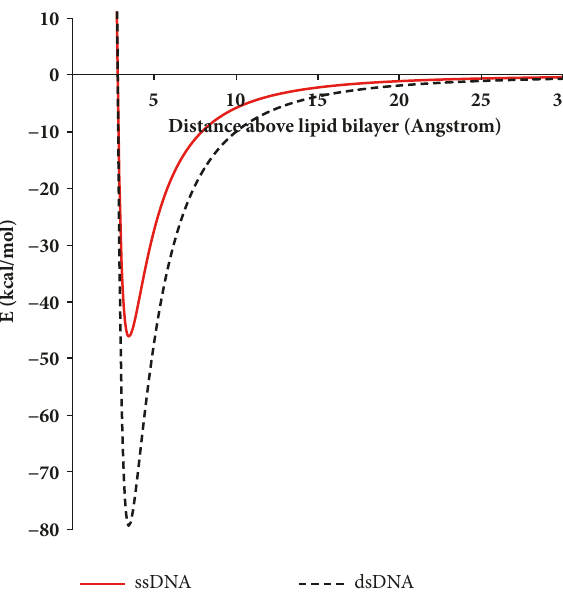
Figure 4: Energy profiles for ssDNA and dsDNA interacting with a lipid bilayer without a